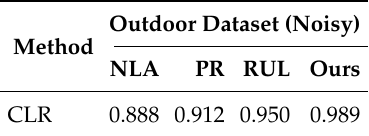
Table 1. Quantitative comparison with other labeling techniques (higher is better; 1 indicates a perfect score). NLA, naive labeling approach; PR, prior information approach; RUL, reference approach from Ulusoy et al.